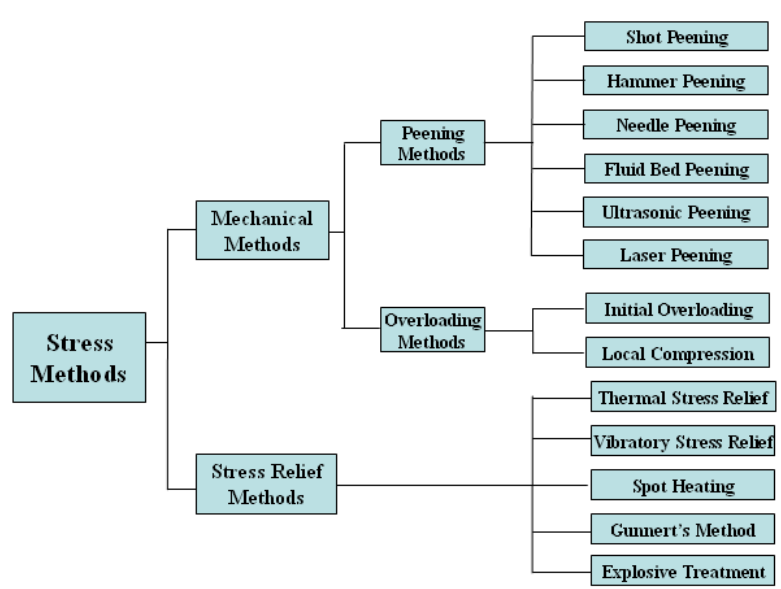
Figure 9: Fatigue improvement techniques.